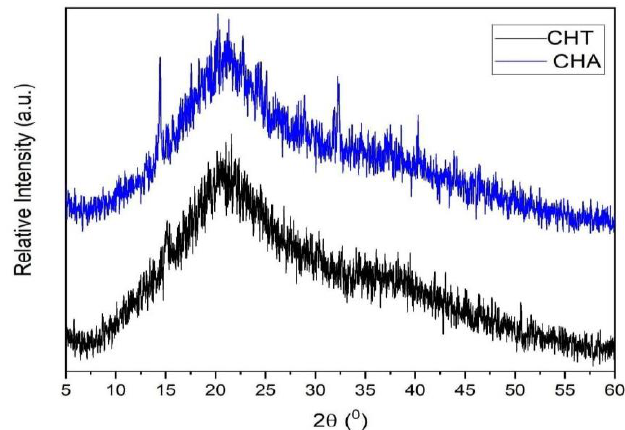
Figure 7. X-ray diffraction of CH films. Table 3. 2θ angle and d -spacing of chañar films bands.